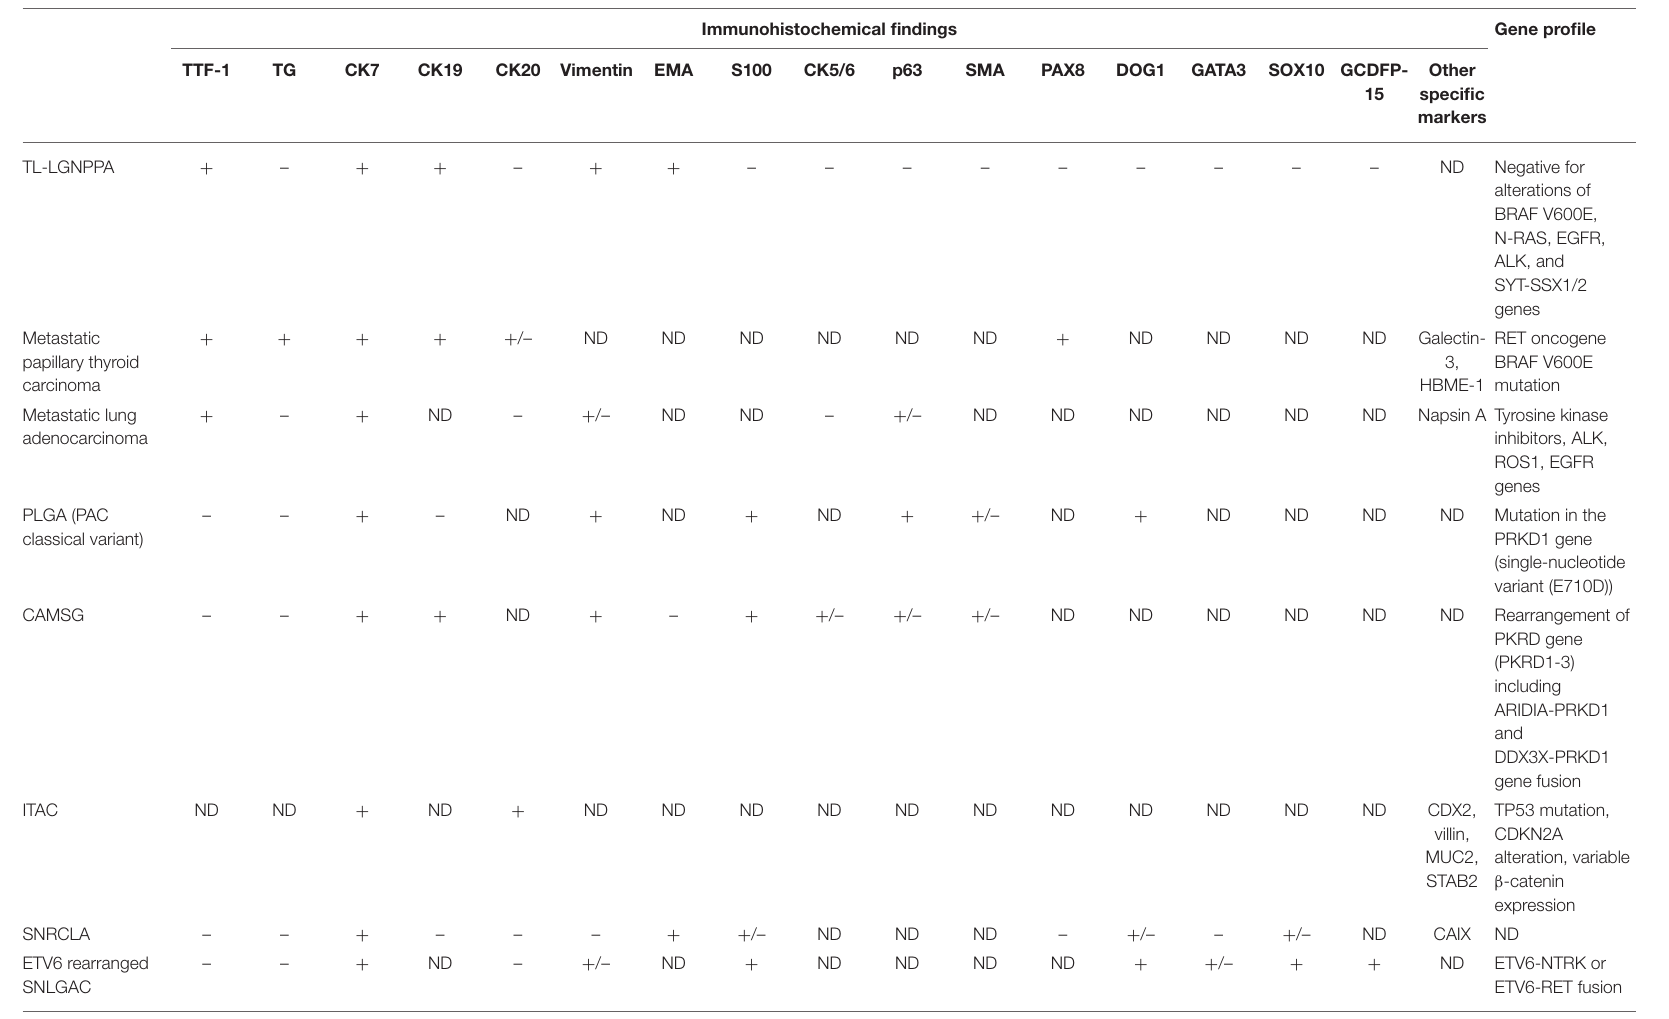
TABLE 3 | Differentiation between TL-LGNPPA and other sinonasal adenocarcinomas [Refer to (33–48,